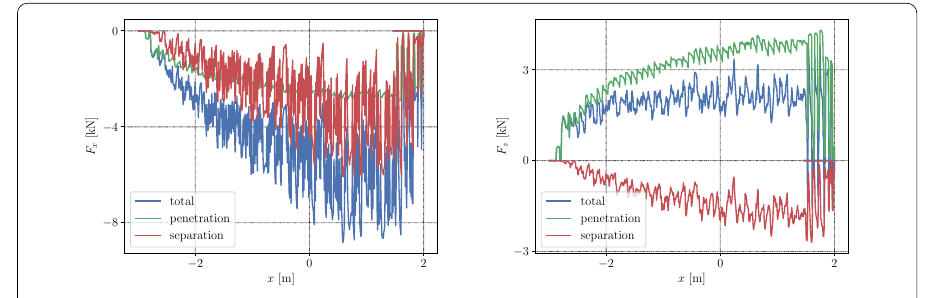
Fig. 11 The digging resistance from bulldozing a bed of sand-1 soil simulated using the multiscale model. The force is divided in the contributions from the penetration and separation